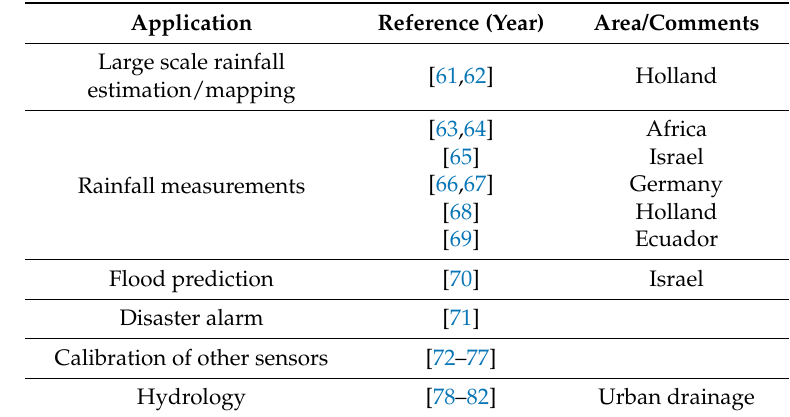
Table 5. Applications and